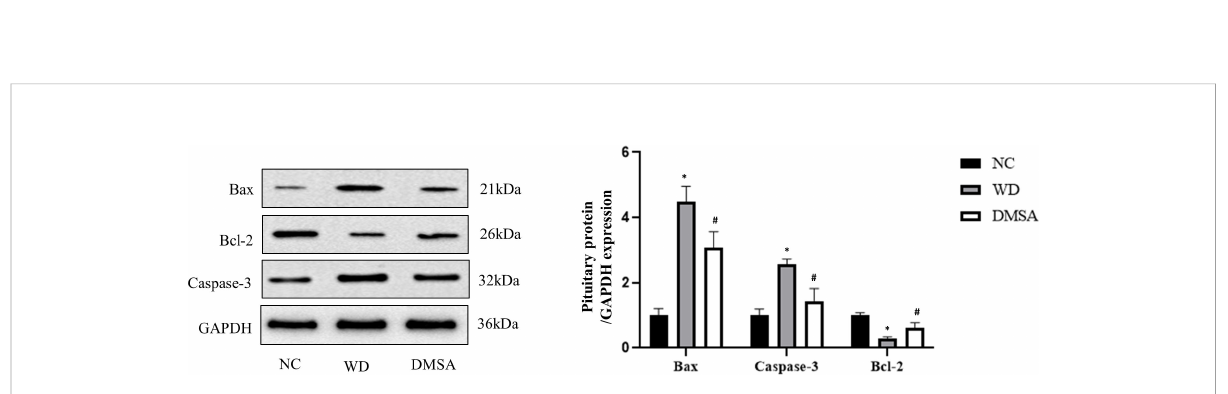
FIGURE 9 Expression levels of Bax, Caspase-3 and Bcl-2 proteins in the male pituitary. Data are presented as mean ± SD. (*P<0.05, NC group vs. WD group; # P<0.05, WD group vs. DMSA group).